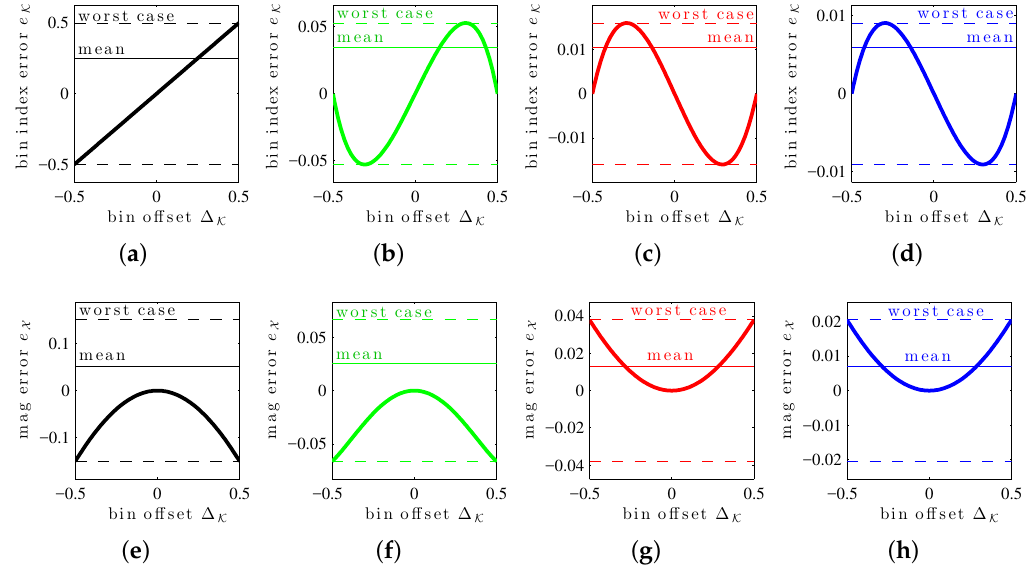
Figure 2. Mean and worst-case of absolute value of errors for each method as a function of bin offset. ( a ) nearest bin method; ( b ) MQIFFT; ( c ) LQIFFT; ( d ) XQIFFT, p = 0.1; ( e ) nearest bin method; ( f ) MQIFFT; ( g ) LQIFFT; ( h ) XQIFFT, p =